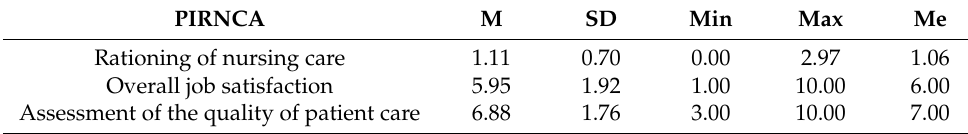
Table 2. Descriptive statistics of care rationing.